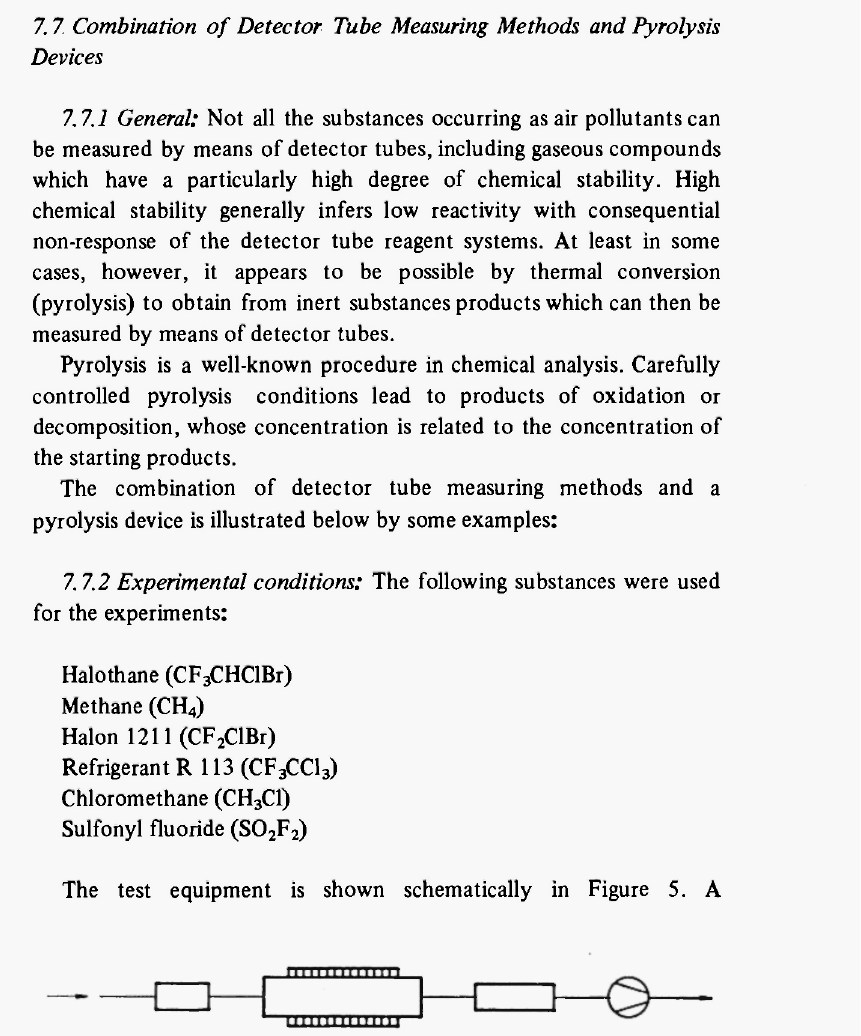
Fig. 5: Pyrolysis system upstream of detector tube for measuring substances of high chemical